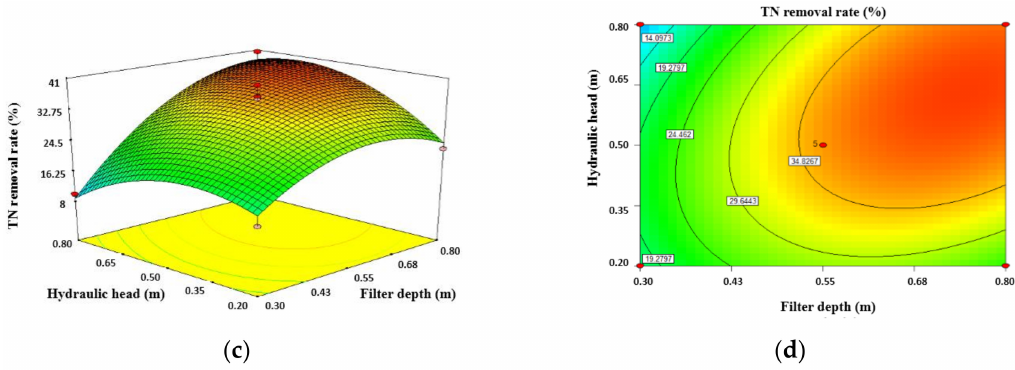
Figure 4. The surface response plots and corresponding contour plots for ( a , b ) NH 3 -N removal rate and ( c , d ) TN removal rate.